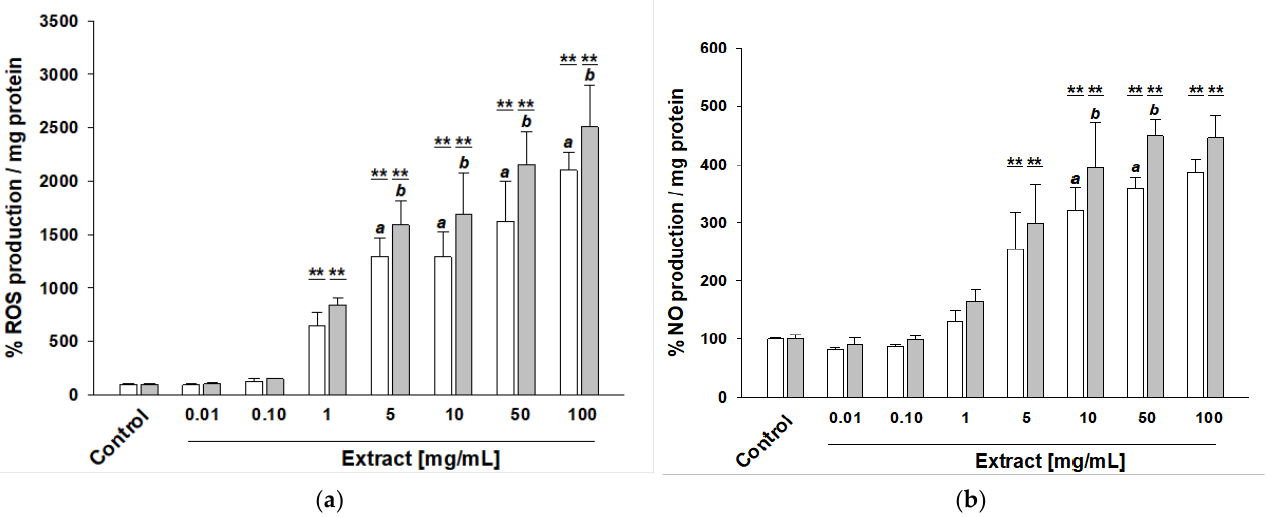
Figure 3. Effect of PAW-rocket salad extract on cellular redox homeostasis. Caco2 cells were treated for 5 h with increasing concentrations of polyphenols (0.01–100 mg/mL) extracted from PAW-20 (white bar) or UT (gray bar) rocket salad. ( a ) Intracellular ROS production was determined by DCFDA ROS Assay Kit (Abcam). ( b ) Intracellular NO production was determined by the Nitric Oxide Assay (Abcam). Control represents Caco2 cells incubated with culture medium containing 0.1% DMSO. Data are presented as the mean ± SD of relative percentage of control sample (set at 100%) obtained from two independent experiments, each carried out in quadruplicate. Statistical significance was calculated by pairwise multiple comparisons for one-way ANOVA followed by Tukey ’s HSD post hoc test. **: significant difference versus control p < 0.01; different letters, when reported, mean significant difference between groups (PAW-20 versus UT at different concentra- tions), p < 0.05.